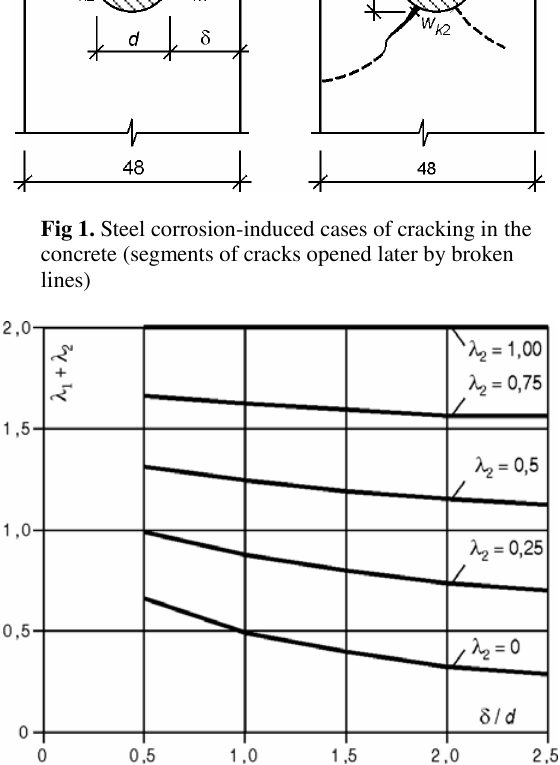
Fig 2. Relationship between the sum of coefficients λ 1 and λ 2 and ratio δ / d